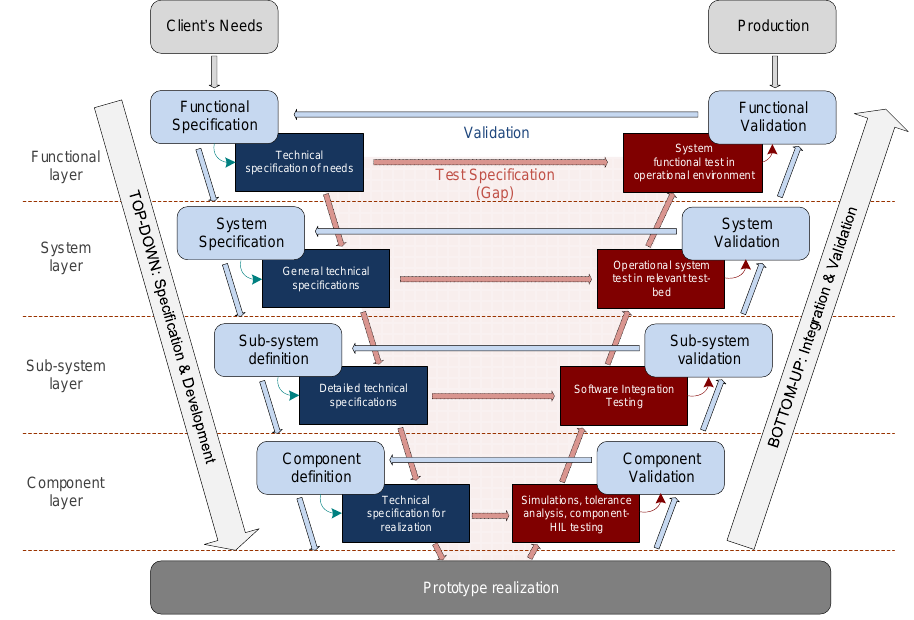
Figure 1. V-model with the associated testing development and the specification gap